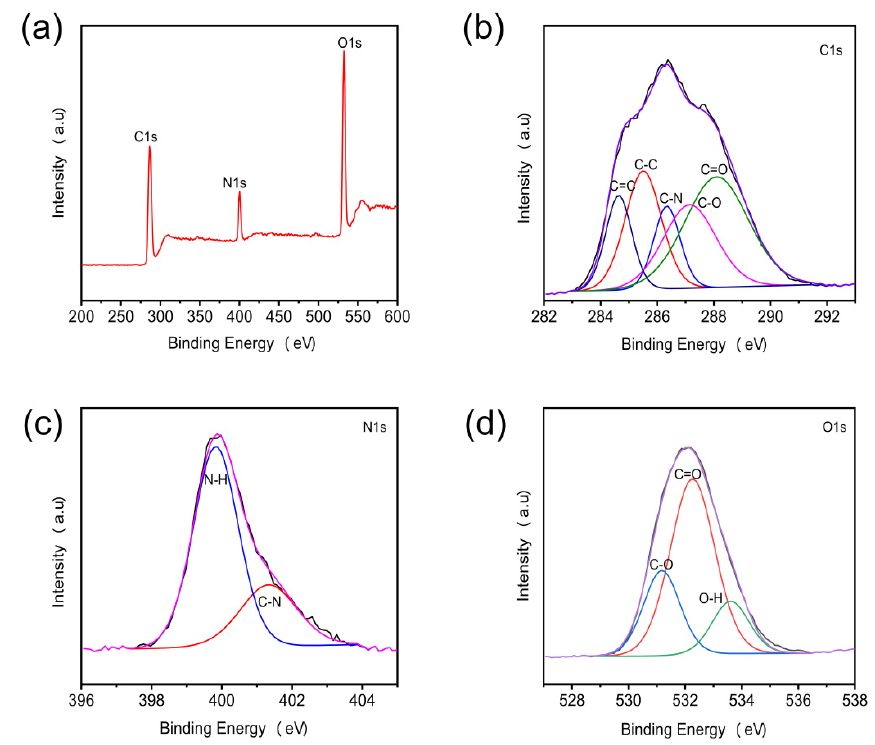
Figure 2. ( a ) XPS spectrum of N-CQDs, and ( b – d ) High resolution XPS spectra of C1s, O1s and N1s of N-CQDs, respectively.